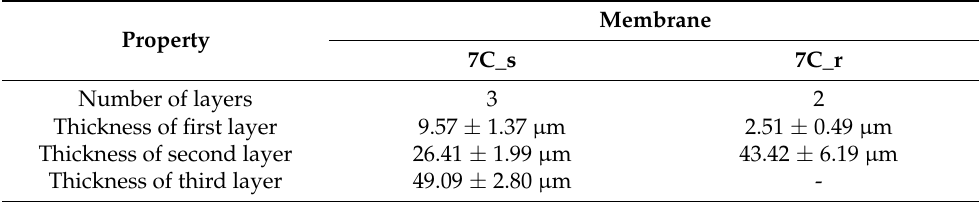
Table 3. Number and thickness of Al 2 O 3 separating layers in the 7C_s and 7C_r membranes. Property